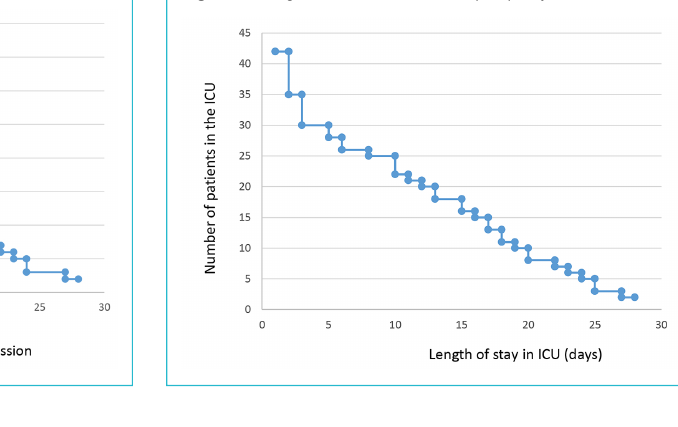
Table 1: Time course of disease severity and therapeutic interventions in the